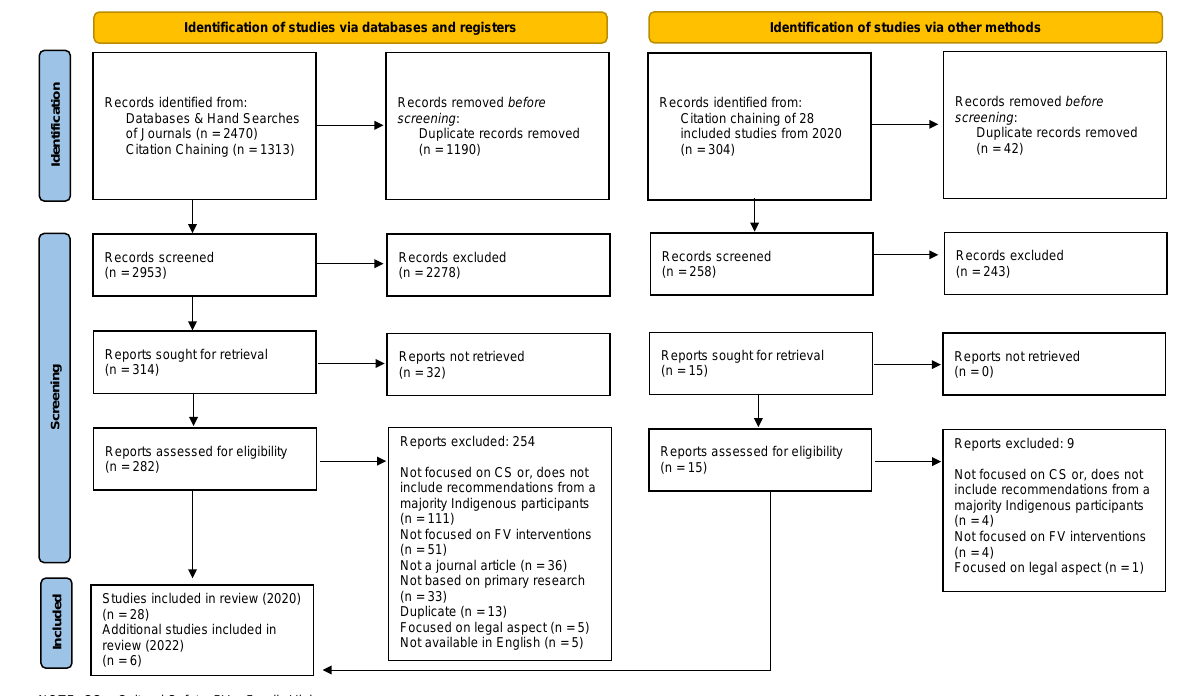
Figure 1. PRISMA Flow Diagram of Included